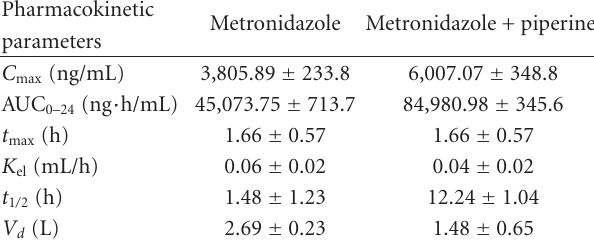
Table 15: Comparative pharmacokinetic parameters after oral administration of metronidazole and in combination with piperine in rabbits